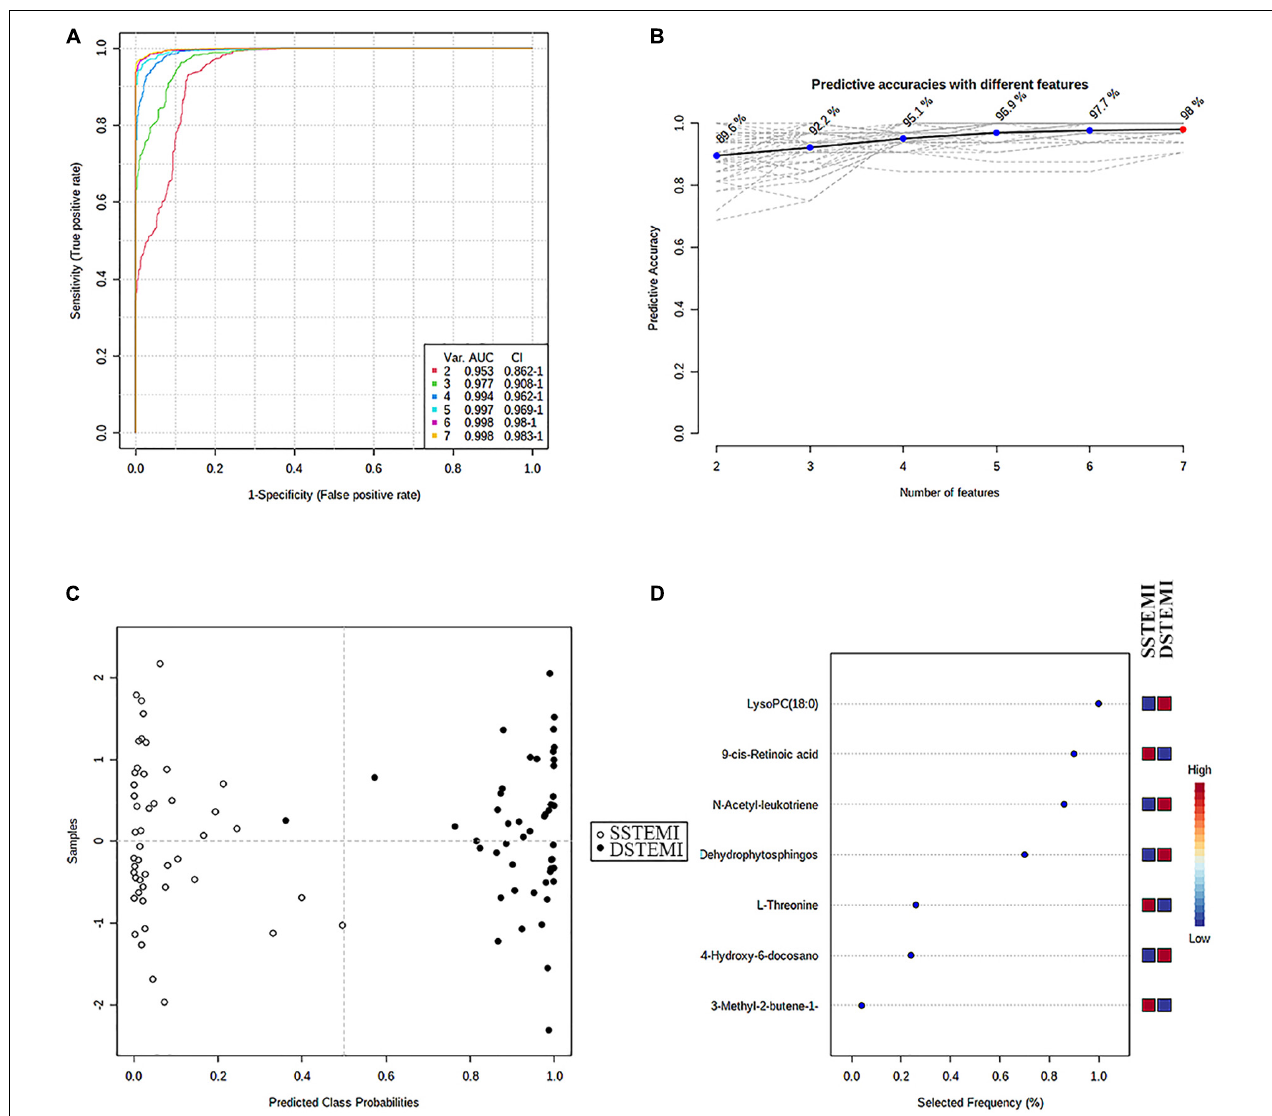
FIGURE 5 | The process of feature selection, model building, and performance evaluation performed multiple times through the Monte-Carlo cross-validation via MetaboAnalyst 5.0 (A) ROC curves of all models based on the cross-validation performance. Model 6 had the largest AUC and (B) the highest predictive accuracy. One DSTEMI sample goes into SSTEMI samples in predicted class probabilities (C) . Seven significant features ranked based on their frequencies of being selected (D) during cross-validation.